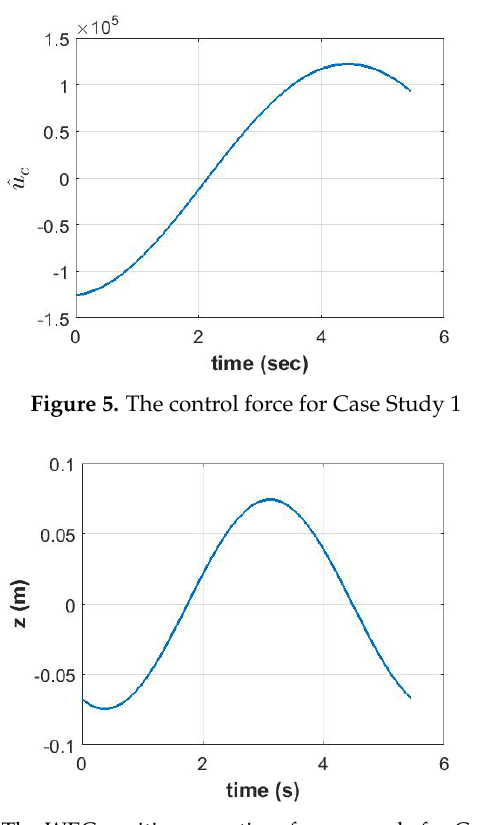
Figure 6. The WEC position over time for one cycle for Case study 1.